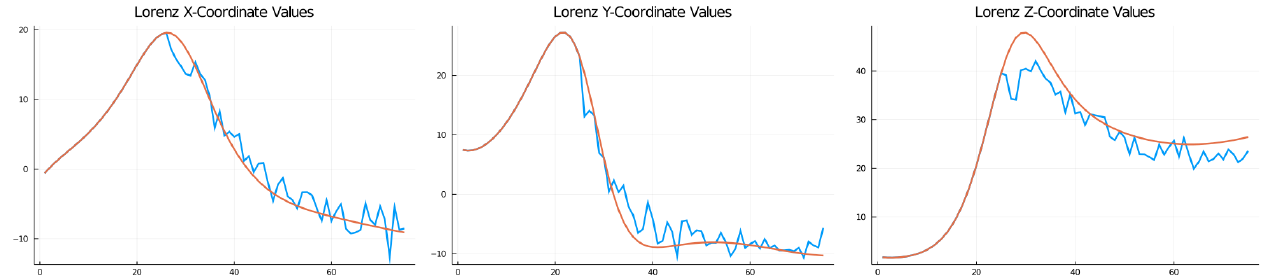
Figure 9. 50-step ahead predicted coordinate values.